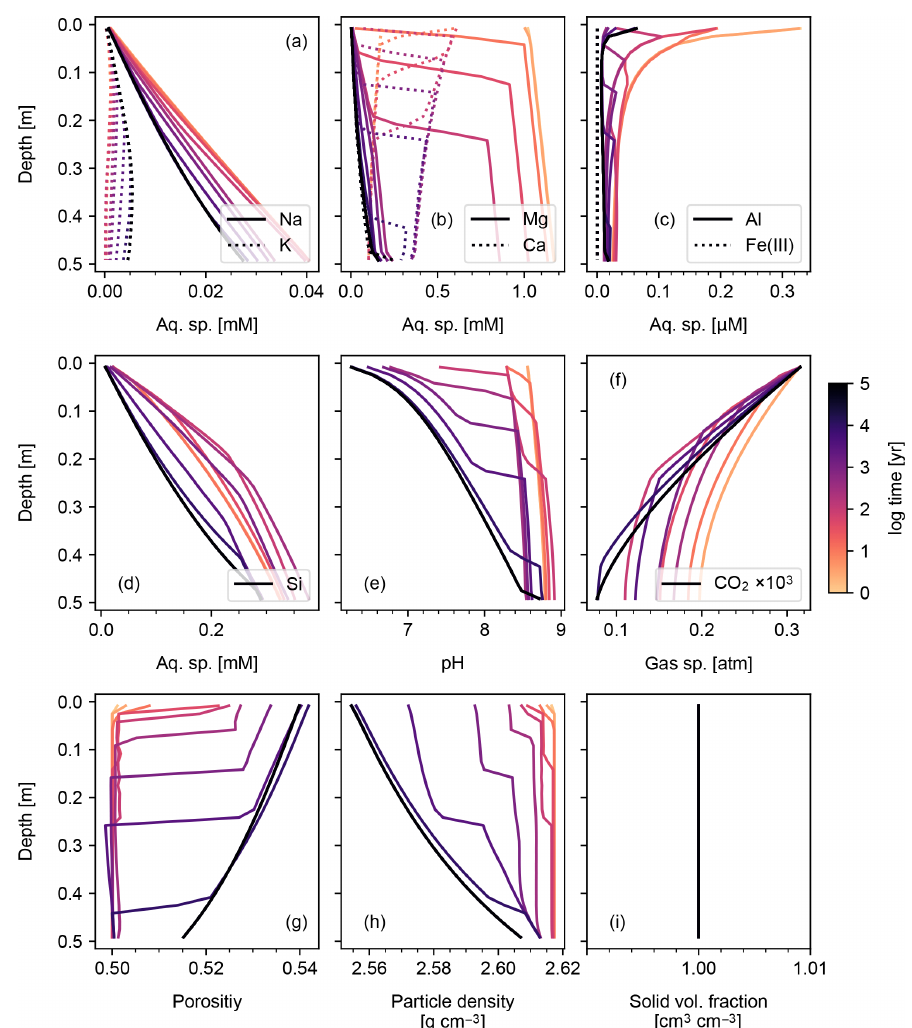
Figure 4. Simulation of abiotic weathering at Site 1 in Table 8. Porewater concentrations of aqueous species and pH are plotted in (a) – (d) and (e) , respectively; concentrations of soil gases in (f) ; soil porosity and particle density in (f) and (g) , respectively; ratio of the total volume of solid species against solid space specified with porosity in (h) . See Table 7 for details on the boundary conditions of the simulation.